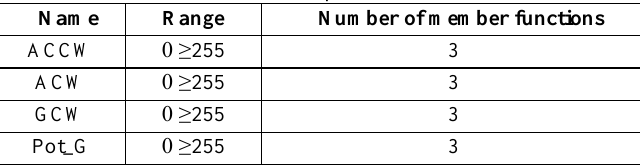
Table 2: Output variables.